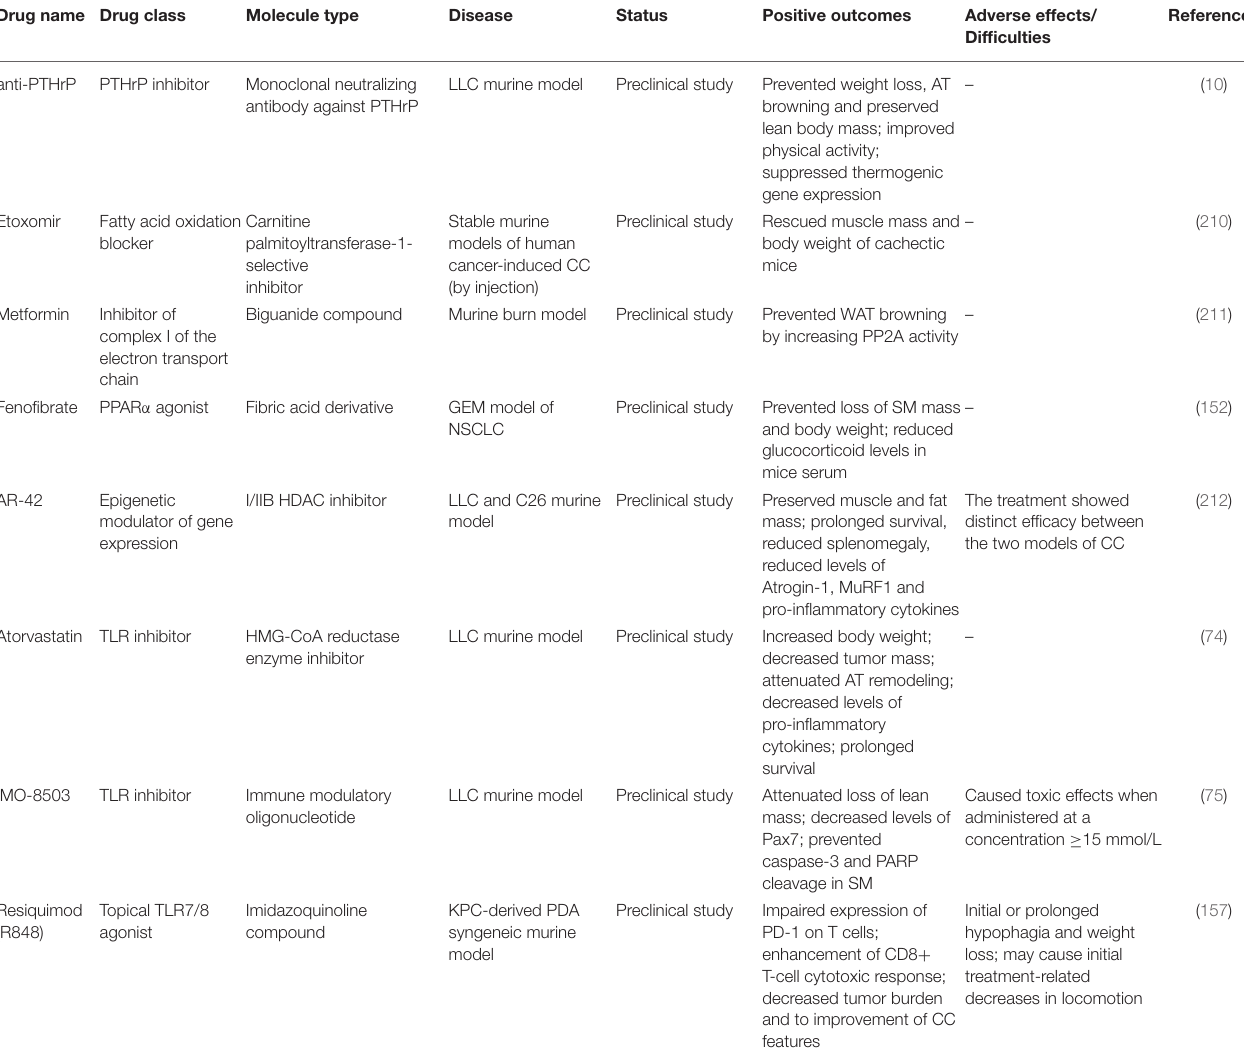
TABLE 2 | Table summarizing emergent unimodal treatment options for CC recently tested in preclinical